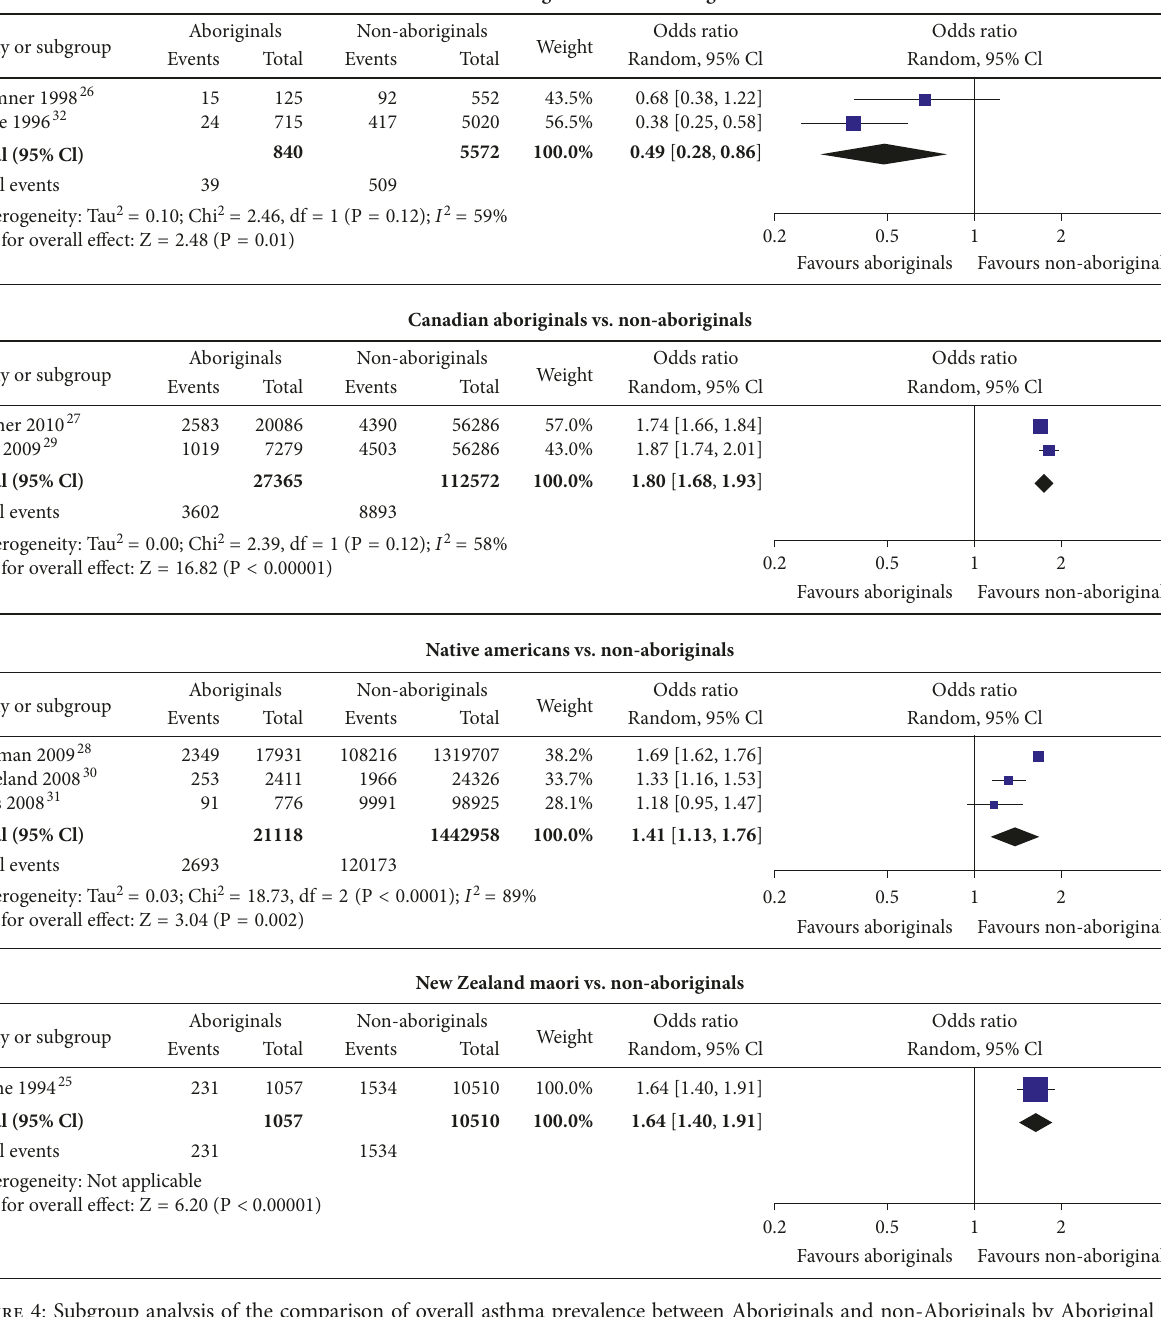
Figure 4: Subgroup analysis of the comparison of overall asthma prevalence between Aboriginals and non-Aboriginals by Aboriginal